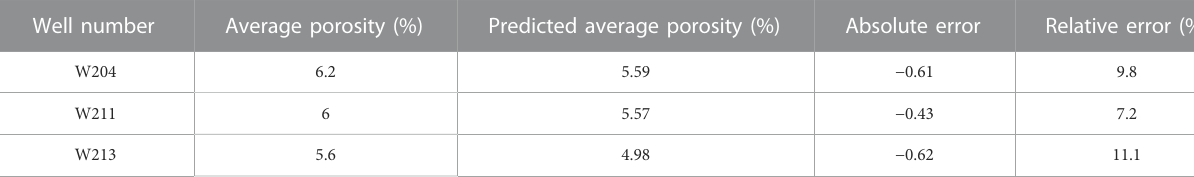
TABLE 5 Statistical table of porosity prediction error of high-quality shale.